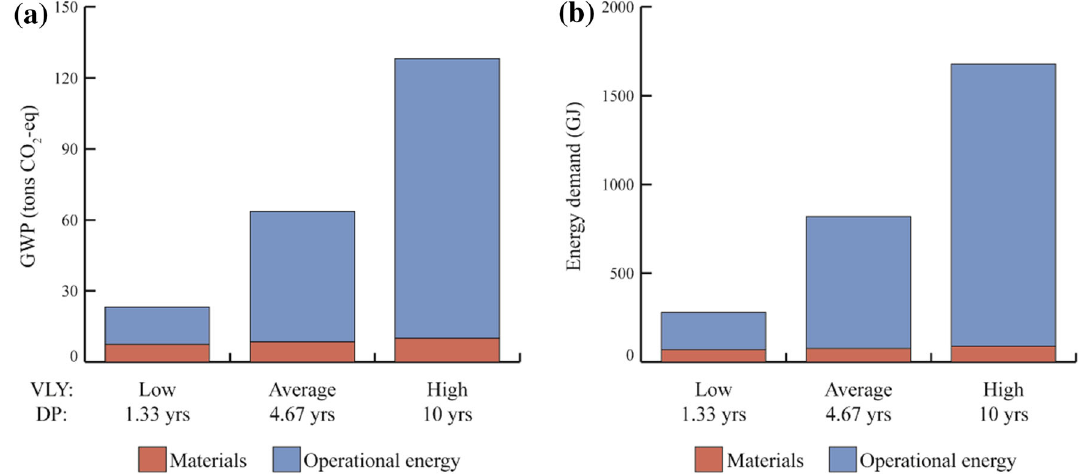
Fig. 1 Global warming potential (GWP) ( a ) and energy demand ( b ) of a single temporary housing intermodal steel building unit by relative social vulnerability. VLY: vulnerability; DP: displacement period